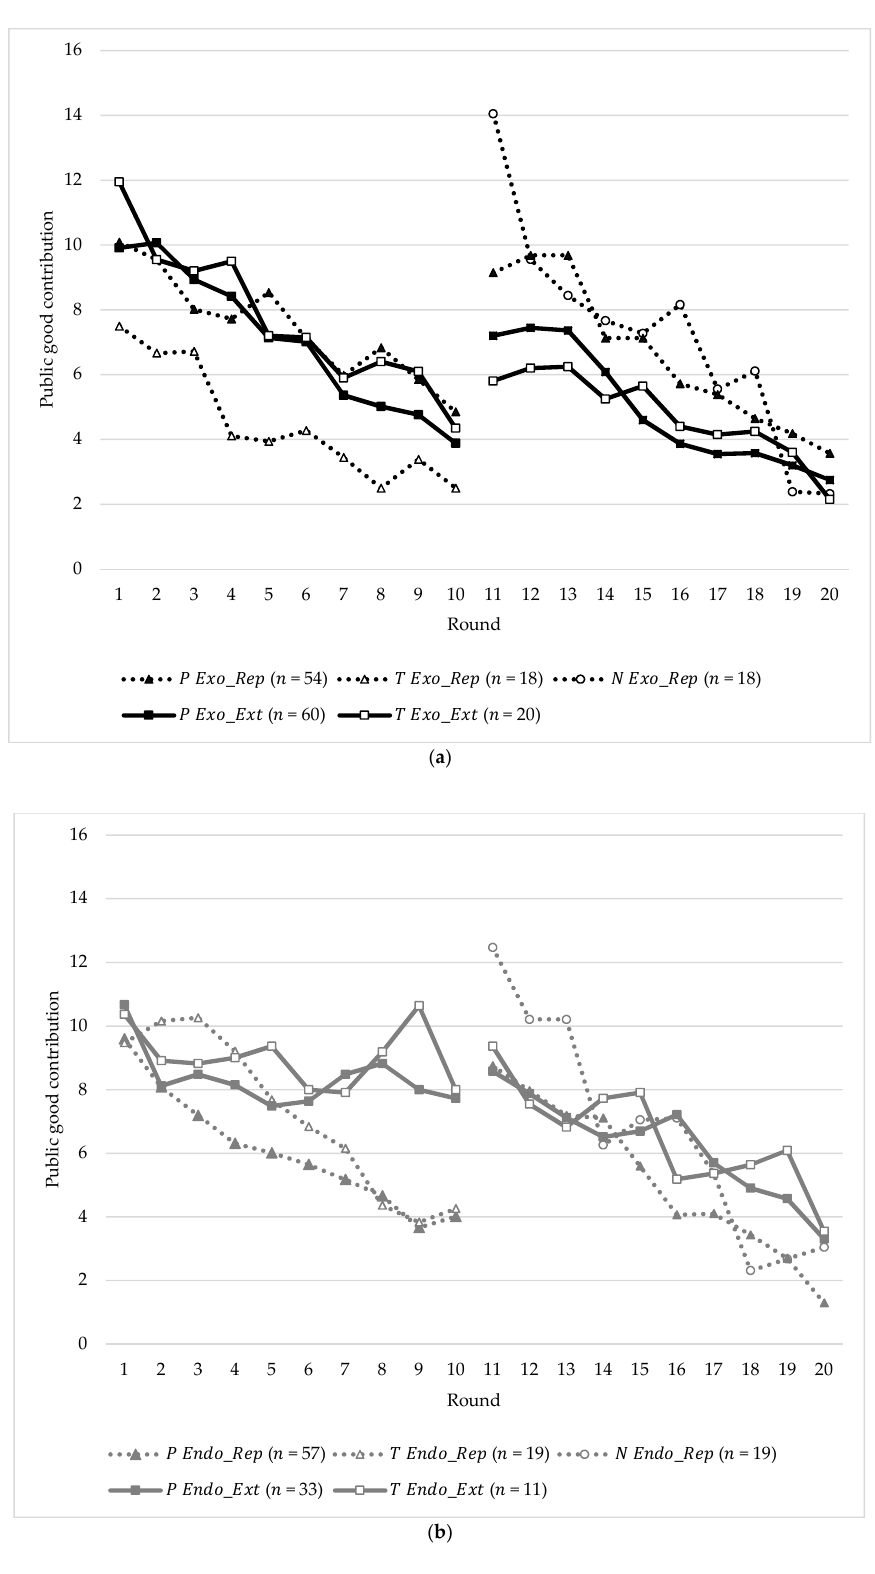
Figure 3. ( a ) Mean contribution over rounds in Exo by player type. ( b ) Mean contribution over rounds in Endo by player type.